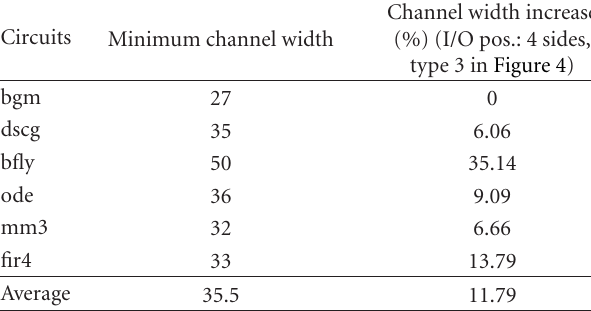
Table 5: Minimum channel width of multiple EB types